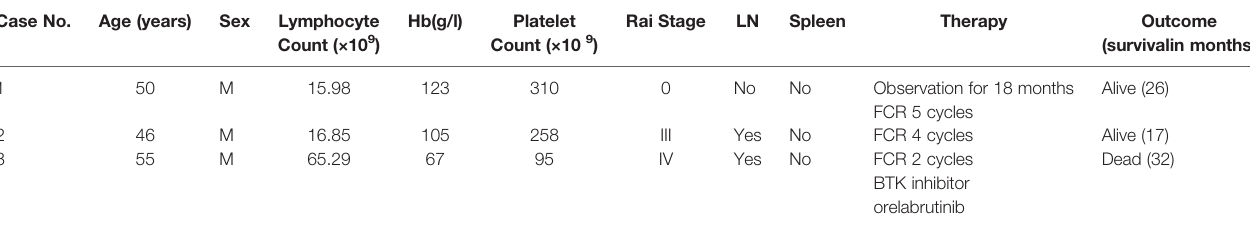
TABLE 1 | Clinical features.